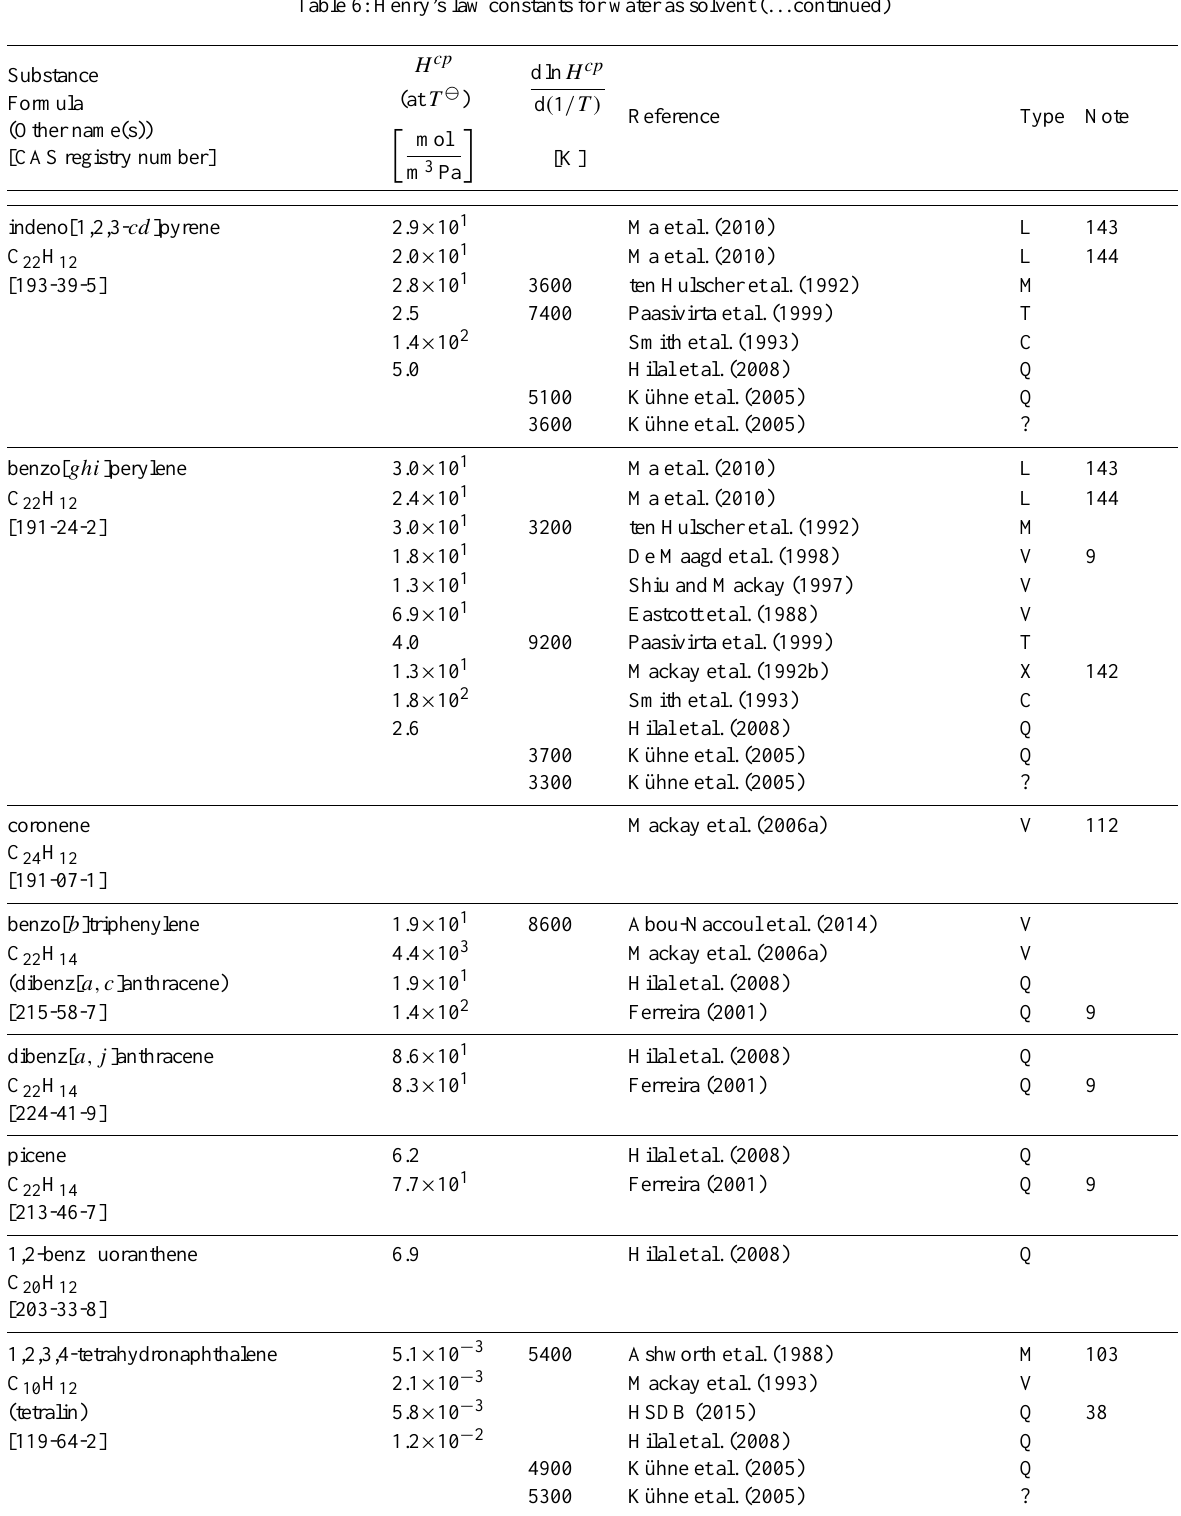
Table 6: Henry’s law constants for water as solvent